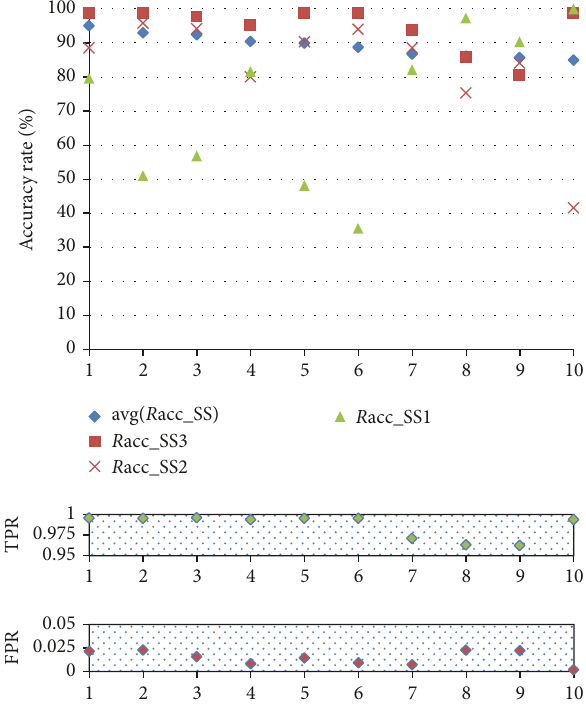
Figure 10: Prediction results of the top 10 parameter combinations for